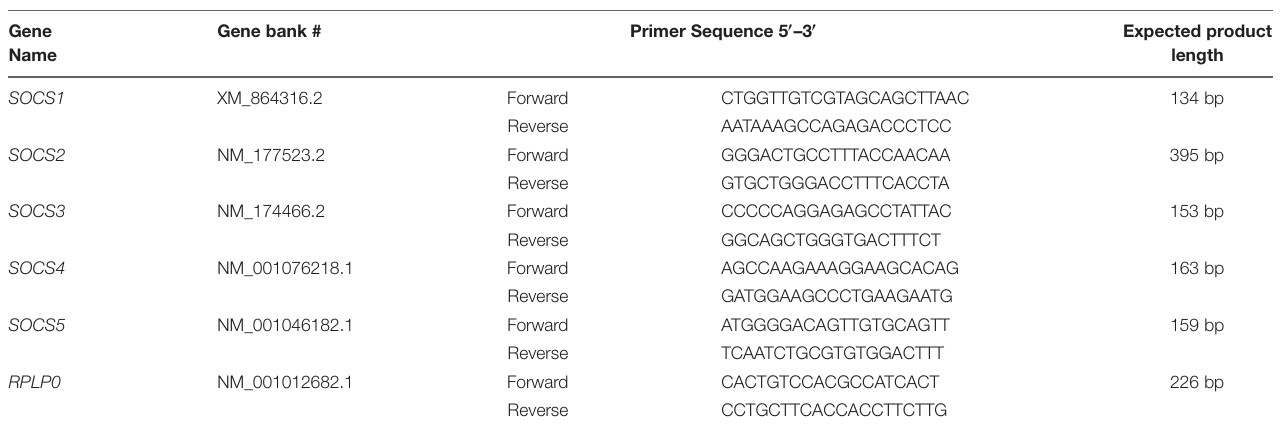
TABLE 1 | Details of primers used for